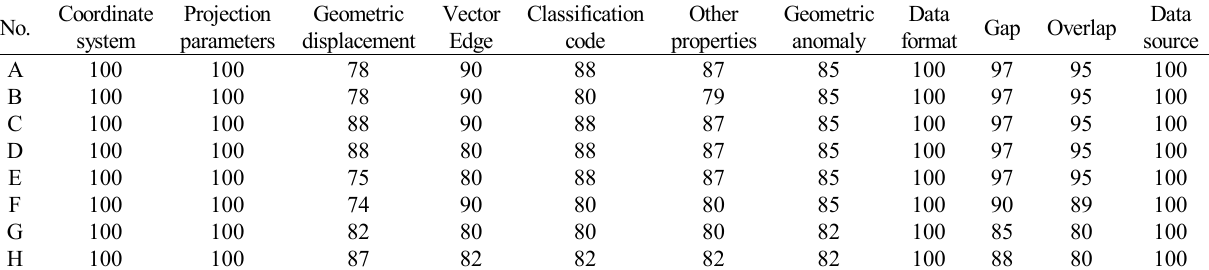
Table 3. Score of inspection items for land cover classification data in an area